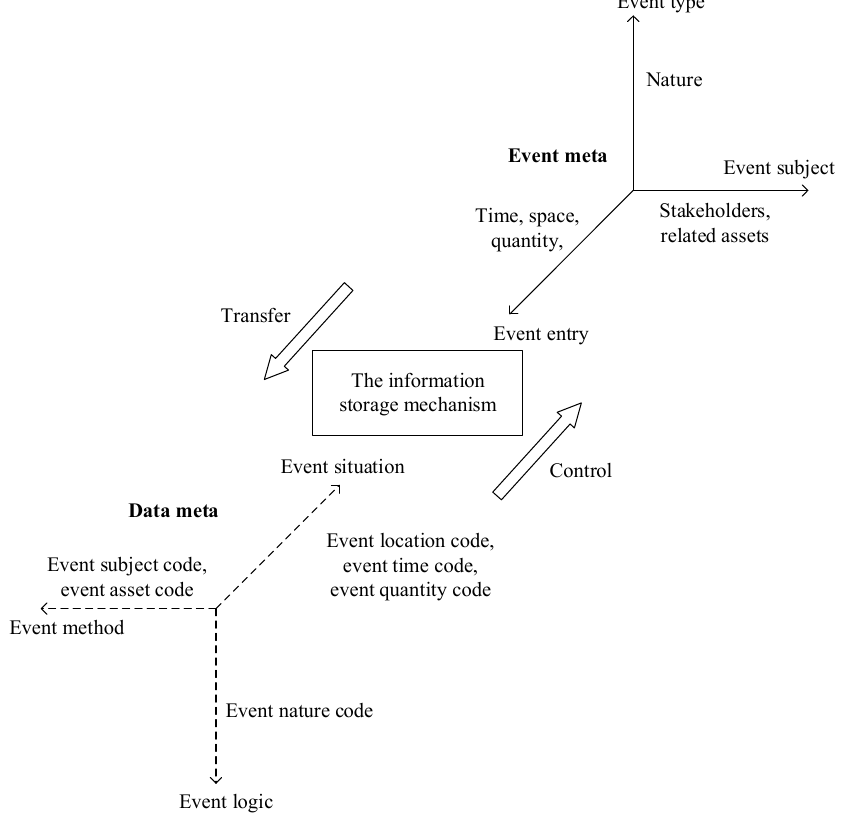
Figure 5. Explosion structure of event meta based on the information storage mechanism.